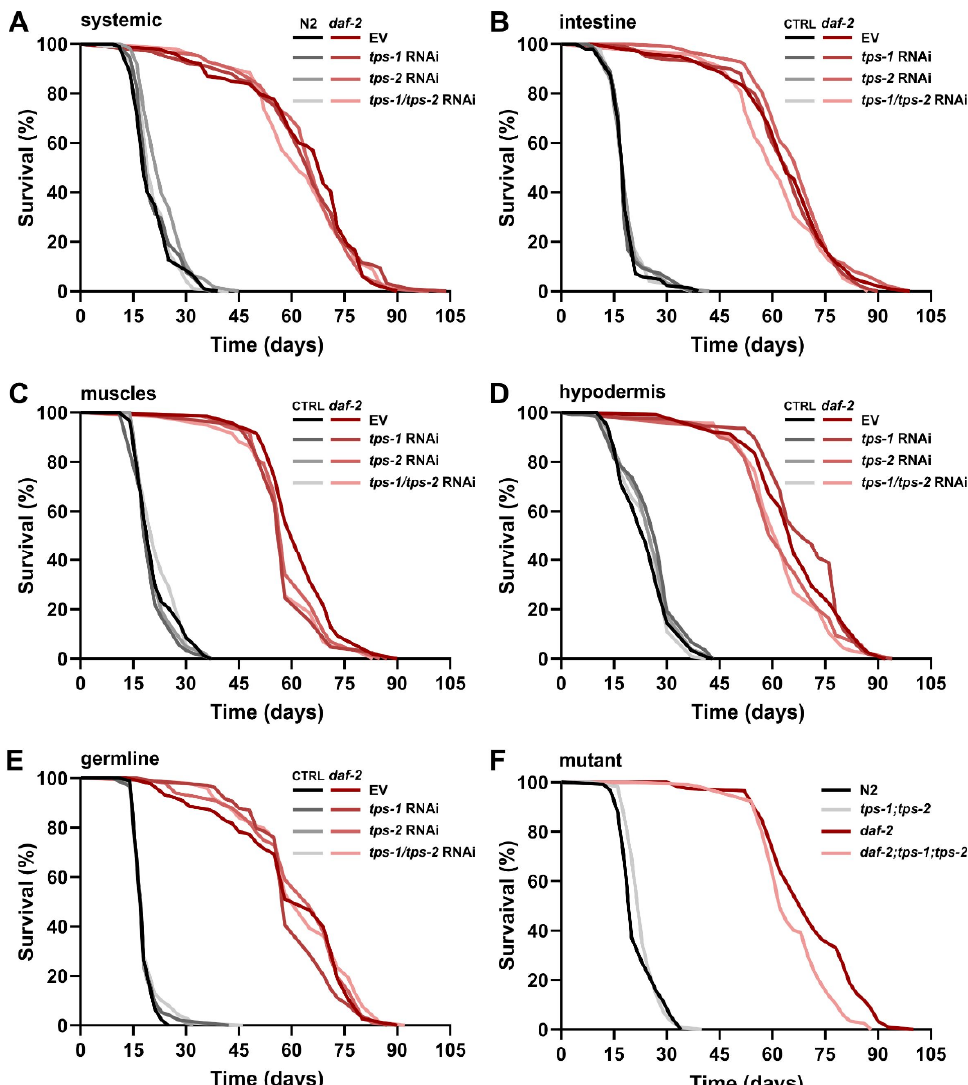
Figure 2. The effect of trehalose synthesis capacity on daf-2(e1370) longevity: ( A – E ) Tissue-specific RNAi of tps genes, ( A ) systemic RNAi, ( B ) intestine-specific RNAi, ( C ) muscle-specific RNAi, ( D ) hypodermis-specific RNAi, ( E ) germline-specific RNAi. Tissue-specific RNAi strains used are listed in Table S1. ( F ) Lifespan of the double tps deletion mutant tps-1(ok373) ; tps-2(ok526) in a wild-type and daf-2(e1370) background. All data are summarized in Table S2.